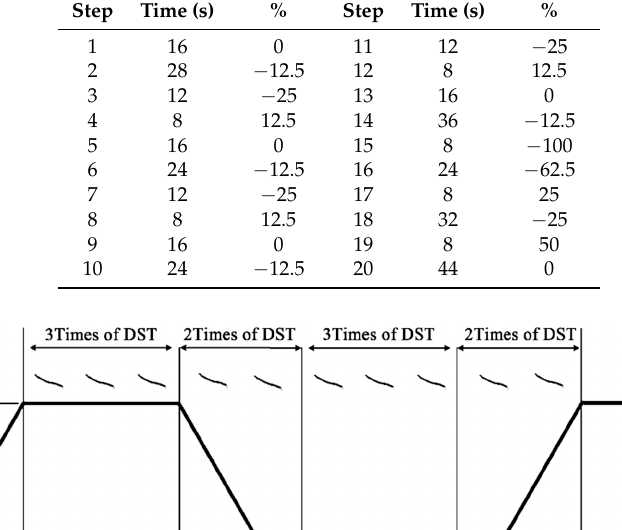
Table 3. Test procedure of the DST.